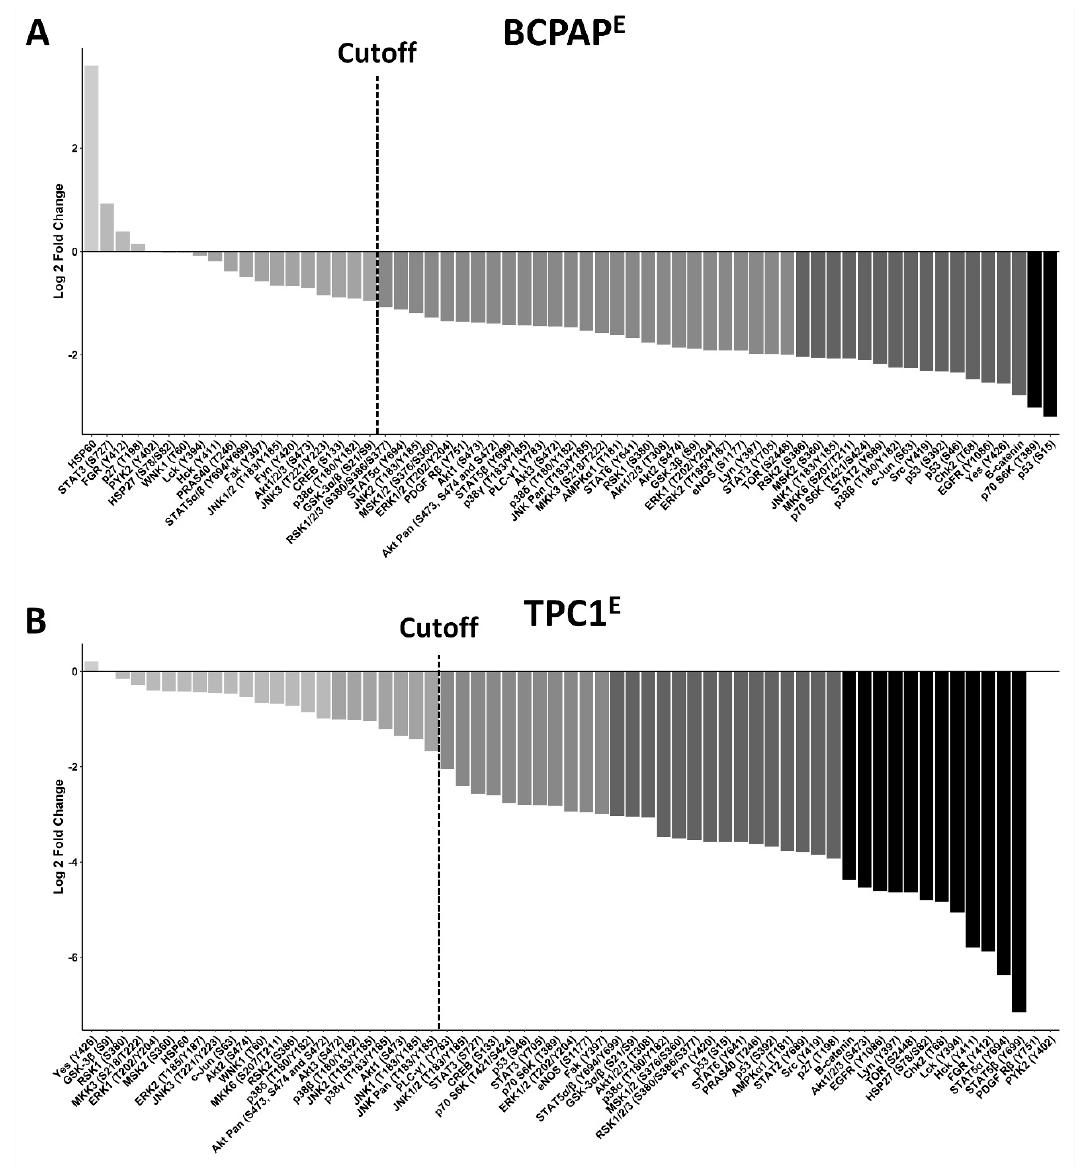
Figure 6. LIMD2 knockout significantly reduced phosphorylation of nearly 60 kinases. The Human Phospho-MAPK and Human Phospho-Kinase Antibody Array Kit were assessed in LIMD2-edited cells (BCPAP E and TPC1 E ) and parental cells. ( A ) BCPAP P ; ( B ) TPC1 P . Log graph based on the fold change of all kinases analyzed in the proteome profiler array, showing that the LIMD2 KO reduced the phosphorylation levels of the majority of kinases analyzed.